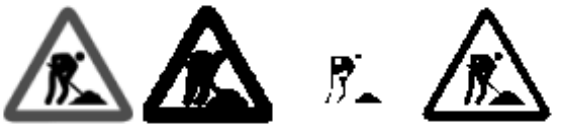
Figure 6. Process to find the optimal thresholding for the P-Tile Method. From left to right: gray scale image, thresholding at GSV = 254, thresholding at GSV = 1, thresholding at GSV = 90.